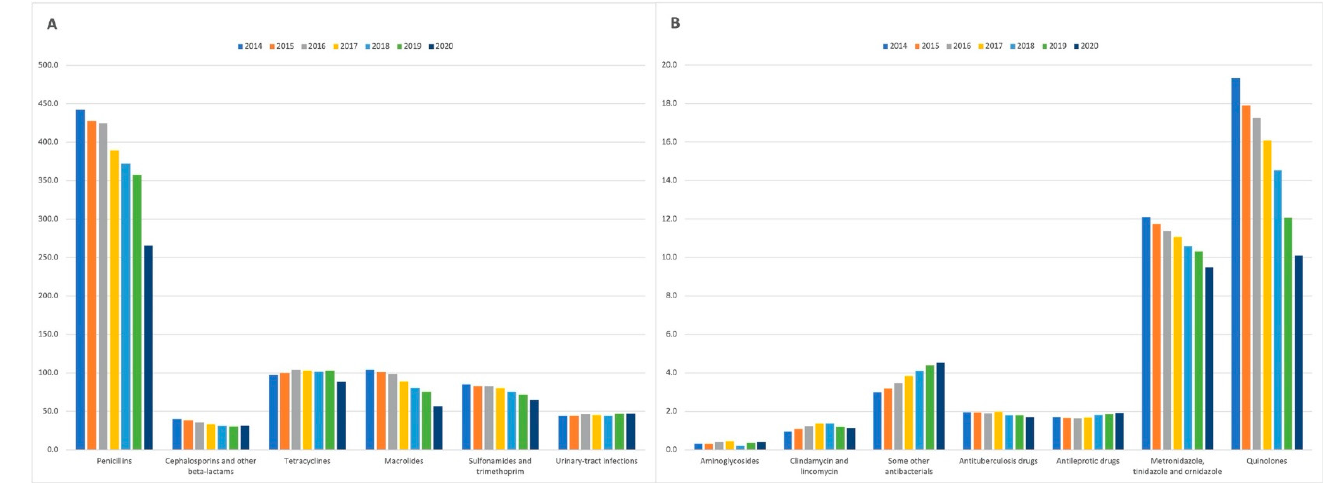
Figure 2. The standardised number of prescriptions for antibiotic classes ( A ) with the average an- nual prescribing rate > 20 prescriptions per 1000 patients; ( B ) with the average annual prescribing rate < 20 prescriptions per 1000 patients. Some other antibacterials include glycopeptide antibacterials, fidaxomicin, linezolid, polymixins, and rifaximin.